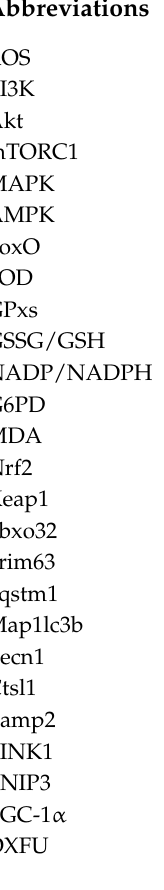
Figure S1: Atrogene expression in sedentary and exercised tumor-bearing mice, Figure S2: Chemotherapy exacerbates muscle wasting and oxidative stress in tumor-bearing mice, Figure S3: Exercise does not considerably impinge on muscle redox balance in chemotherapy-treated tumor-bearing mice, Table S1: Forward and reverse primer sequences (5 (cid:48) -3 (cid:48) ) of analyzed